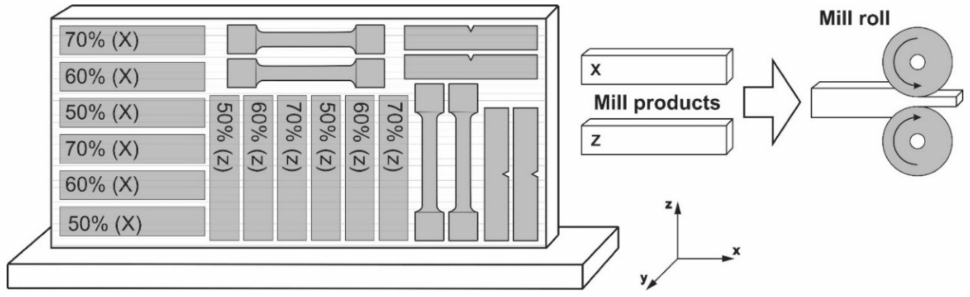
Figure 1. Scheme of cutting and cold rolling of deposited